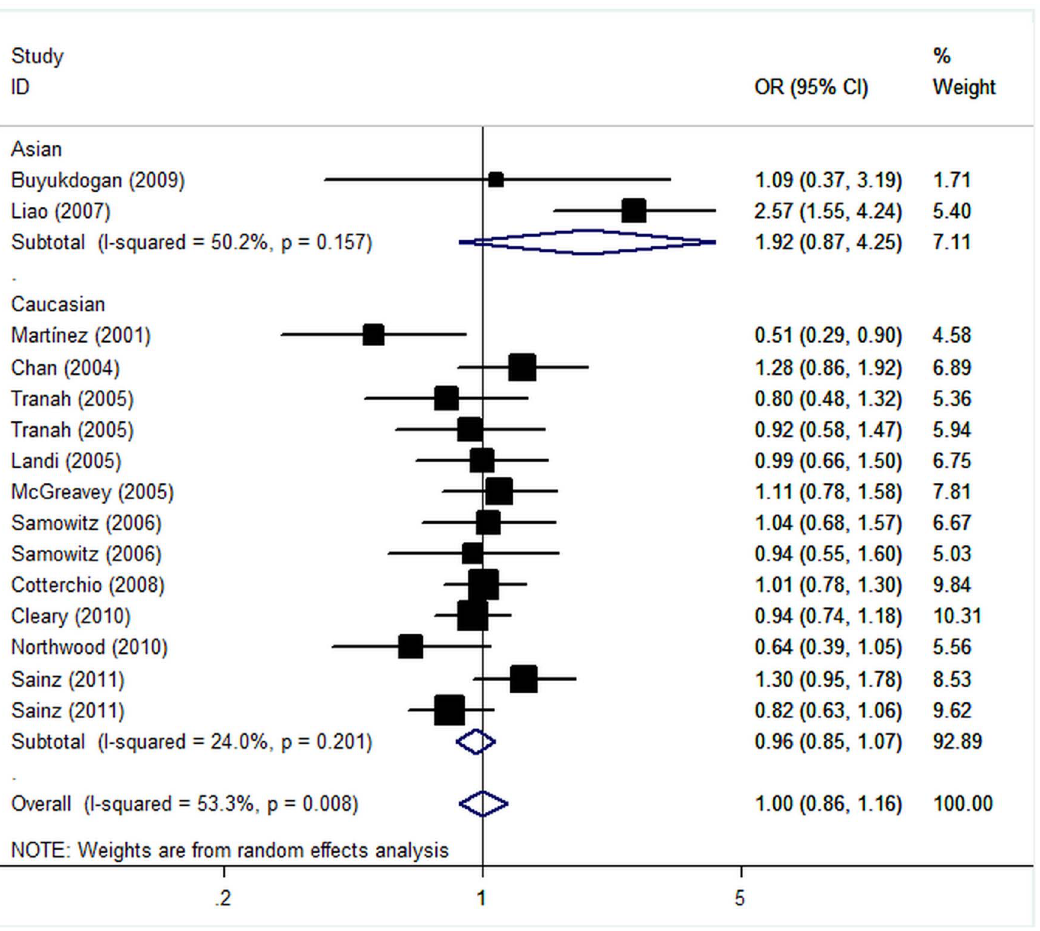
Figure 2. Forest plot (random effects model) of colorectal cancer risk associated with the CYP2C9 *3 carrier of the I359L polymorphism.